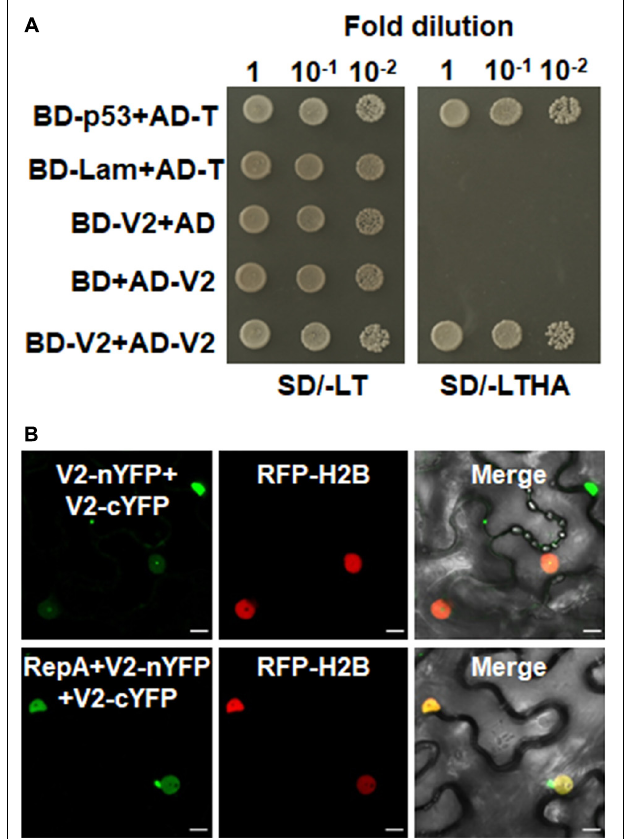
FIGURE 5 | RepA changes the site of V2–V2 self-interaction. (A) Self-interaction of V2 determined by yeast two-hybrid assay. (B) BiFC assays in leave cells of RFP-H2B plants. Self-interaction of V2 in the absence or presence of RepA was examined at 48 hpi using a confocal microscope. YFP signal resulting from interacting protein combinations are indicated as green. RFP-H2B was a marker for the nucleus. Note that the sites of V2–V2 self-interaction was excluded from the nucleolus by RepA. Images are representative of three independent experiments, in each of which at least 20 cells were examined. Scale bars correspond to 10 µ